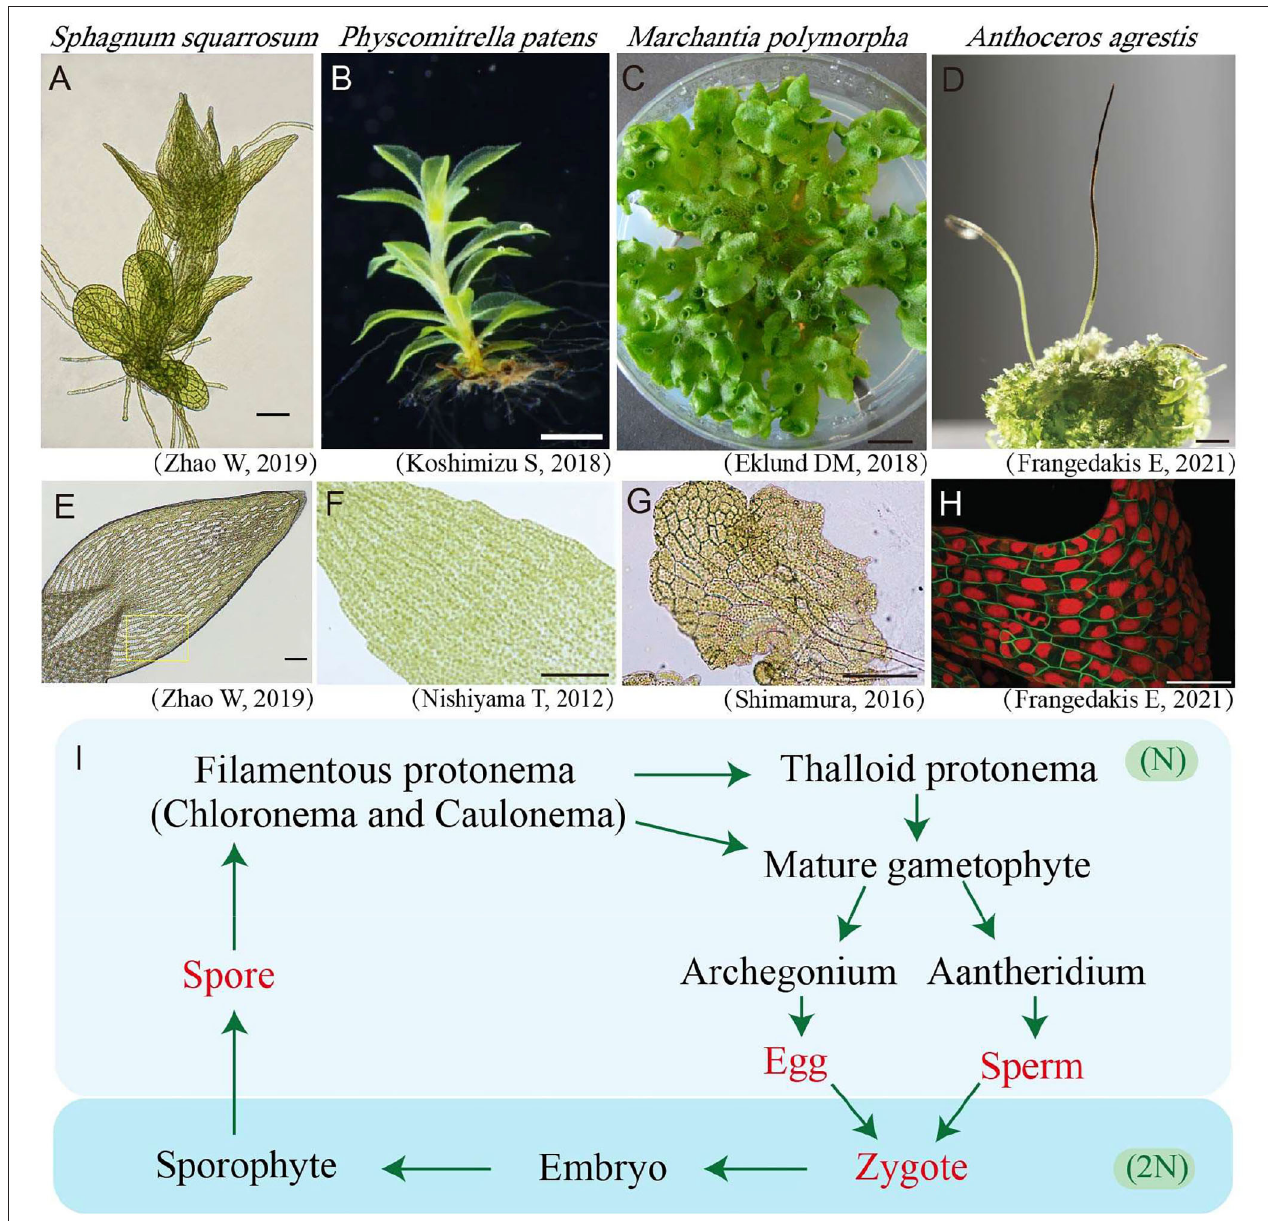
FIGURE 1 | Gametophyte and leaves/thallus cells of bryophytes. (A) Light microscopy photos of young Sphagnum squarrosum gametophyte. Bar = 100 µ m. (B) Photo of Physcomitrella patens’s mature gametophyte (Koshimizu et al., 2018). Bar = 1mm. (C) Photo of Marchantia polymorpha’s mature gametophyte (Eklund et al., 2018). Bar = 1mm. (D) Photo of Anthoceros agrestis gametophyte (the bottom area) and sporophytes (the top slender area). Bar = 3mm. (E) Photo of a leaf with green and white cells in S. squarrosum (Li et al., 2019). Bar = 100 µ m. (F) Light microscopy photo of a leaf in P. patens (Nishiyama et al., 2012). Bar = 100 µ m. (G) Light microscopy photo of young thallus cells of M. polymorpha (Shimamura, 2016). Bar = 100 µ m. (H) Confocal fluorescence microscopy image of A. agrestis gametophyte cells in which the plasma membrane is shown in green and the plastid is shown in red (Frangedakis et al., 2021). Bar = 100 µ m. (I) Life cycle of bryophytes. The words in red denote single cell stages while the words in black denote multicellular stages. The light blue background indicates the haploid (N) stages, while the dark blue background indicates the diploid (2N) stages of